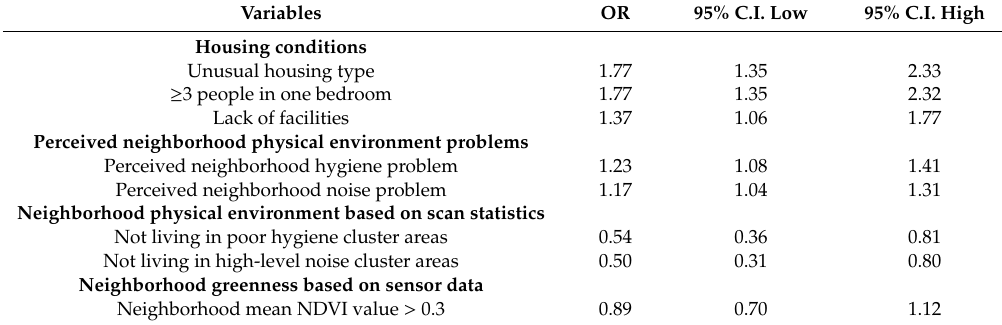
Table 3. Partially adjusted odds ratios (ORs) of housing conditions and neighborhood physical environments on SHS exposure at home among non-smoking migrant workers. C.I.: confidence interval. NDVI: Normalized Di ff erence Vegetation